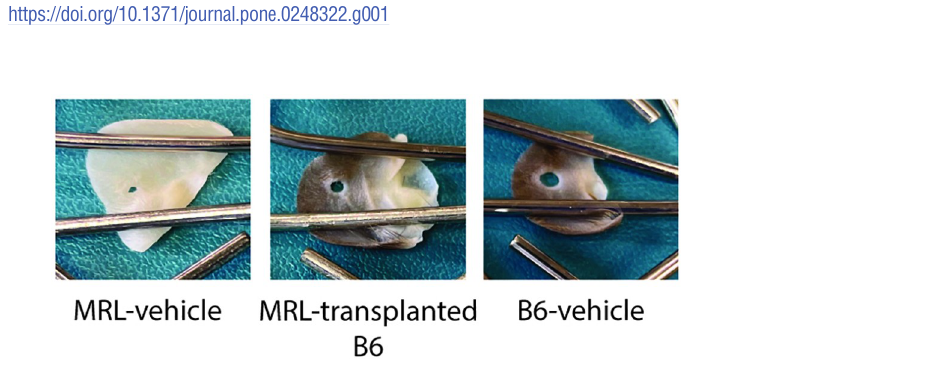
PLOS ONE | https://doi.org/10.1371/journal.pone.0248322 July 20, 2021 6 /